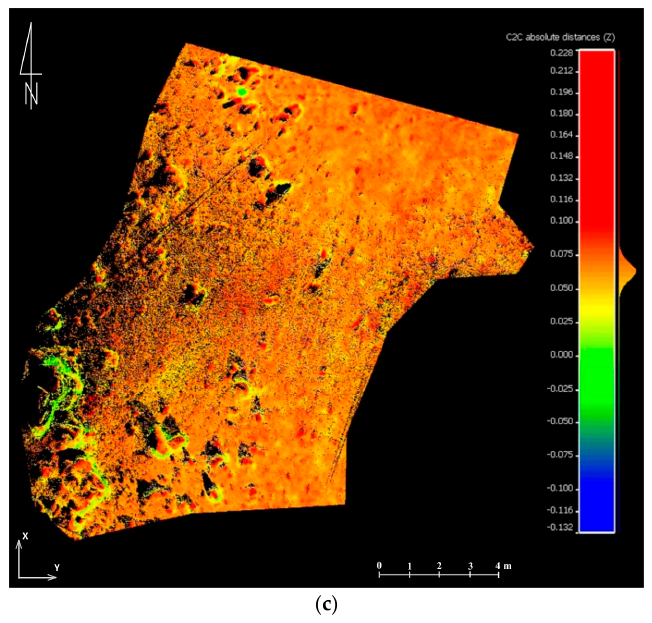
Figure 11. Point clouds from the UAV ( a ) and TLS ( b ) which represent the second test field and results of their comparison ( c ) (source: authors’ own study) (the units given in m). Table 5. Results of comparing the point cloud from TLS with the point cloud and the mesh model from the UAV.